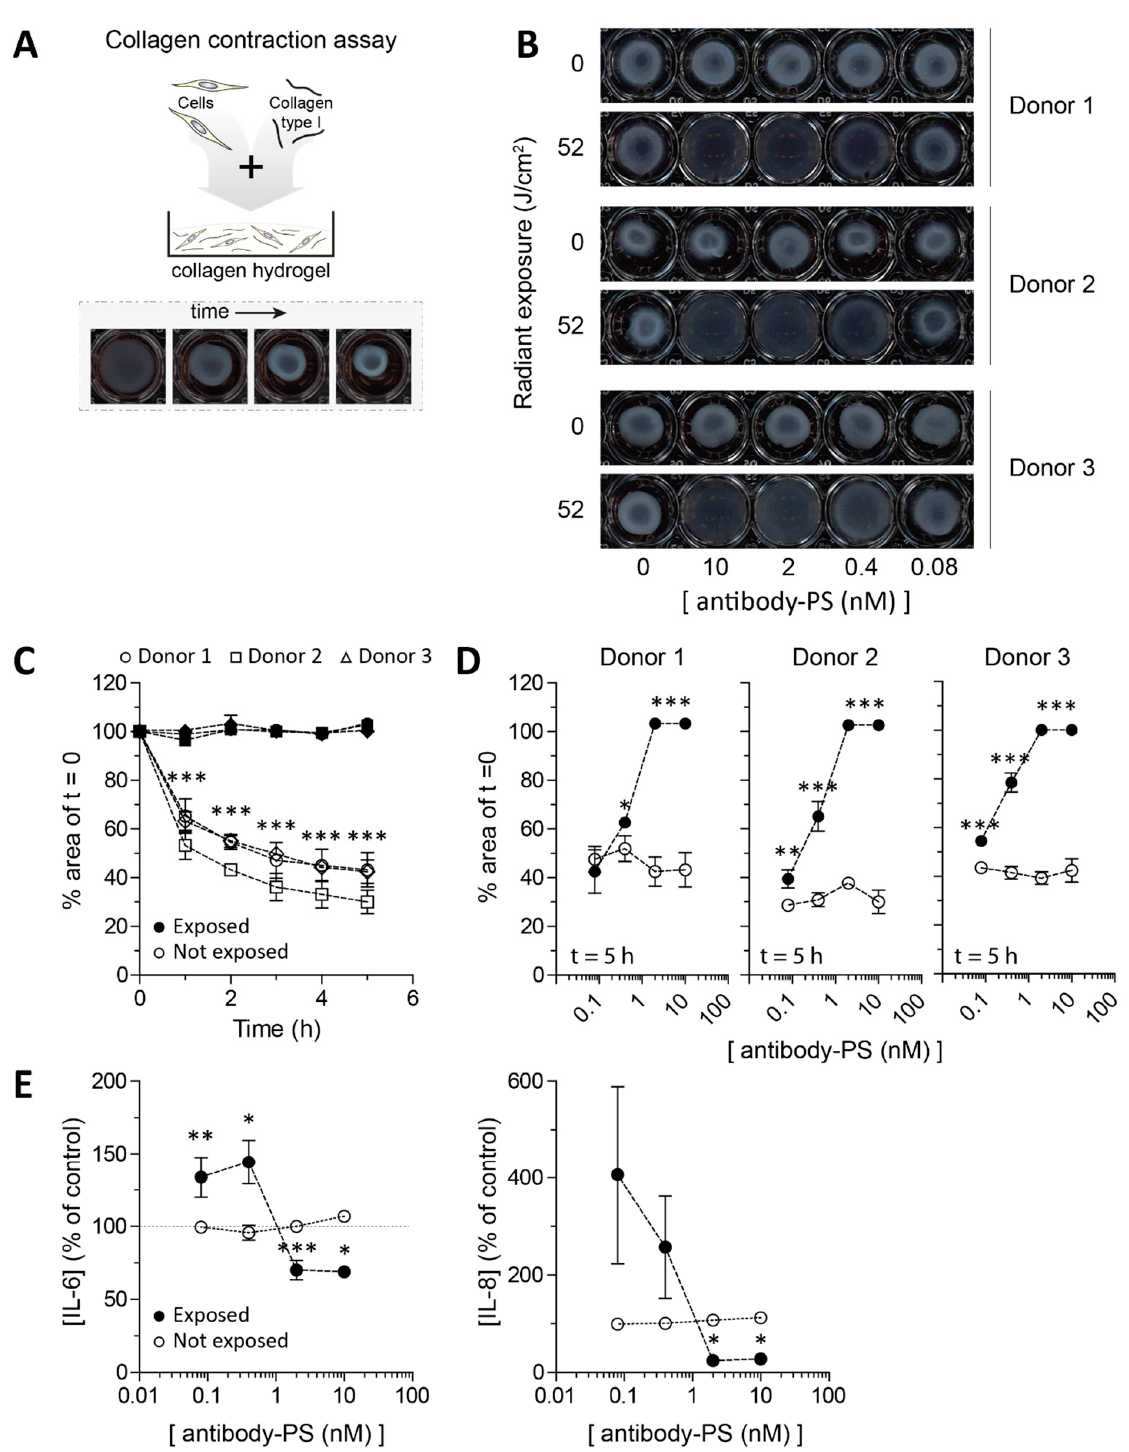
Figure 4. Application of FAP-tPDT in 3D culture of primary lesional SSc skin fibroblasts cultured in collagen type 1 hydrogels. Primary skin fibroblasts of 3 different donors were seeded in collagen type 1 hydrogels ( A ) and exposed to a dose response of tPDT after 48 h. Subsequently contraction was visualized after 5 h ( B ) and quantified over time for a dose of 10 nM PS-antibody construct. In hydrogels not exposed to light, contraction occurs but this is fully blocked by tPDT ( C ). Dose response curves for each individual donor after 5 h are depicted in ( D ) (all n = 4 replicates per donor ) . IL6 and IL8 levels were measured in the supernatant of the hydrogels 5 h after tPDT procedure ( E ). (Pooled data from duplicates of all 3 donors). *= p <0.05, **= p <0.01, ***= p <0.001.